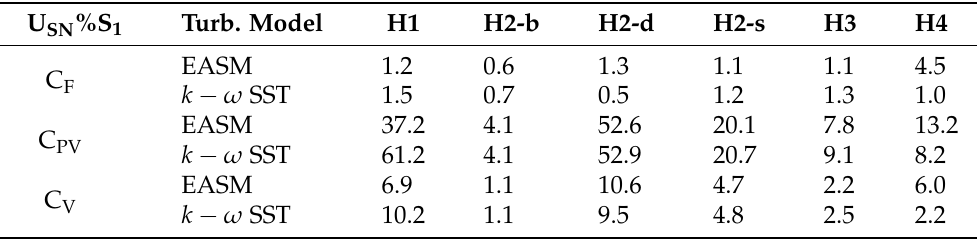
Table 1. Estimated numerical uncertainties of SHIPFLOW in model scale for EASM and k − ω SST turbulence models, in a percentage of the computed result of the finest grid, S 1